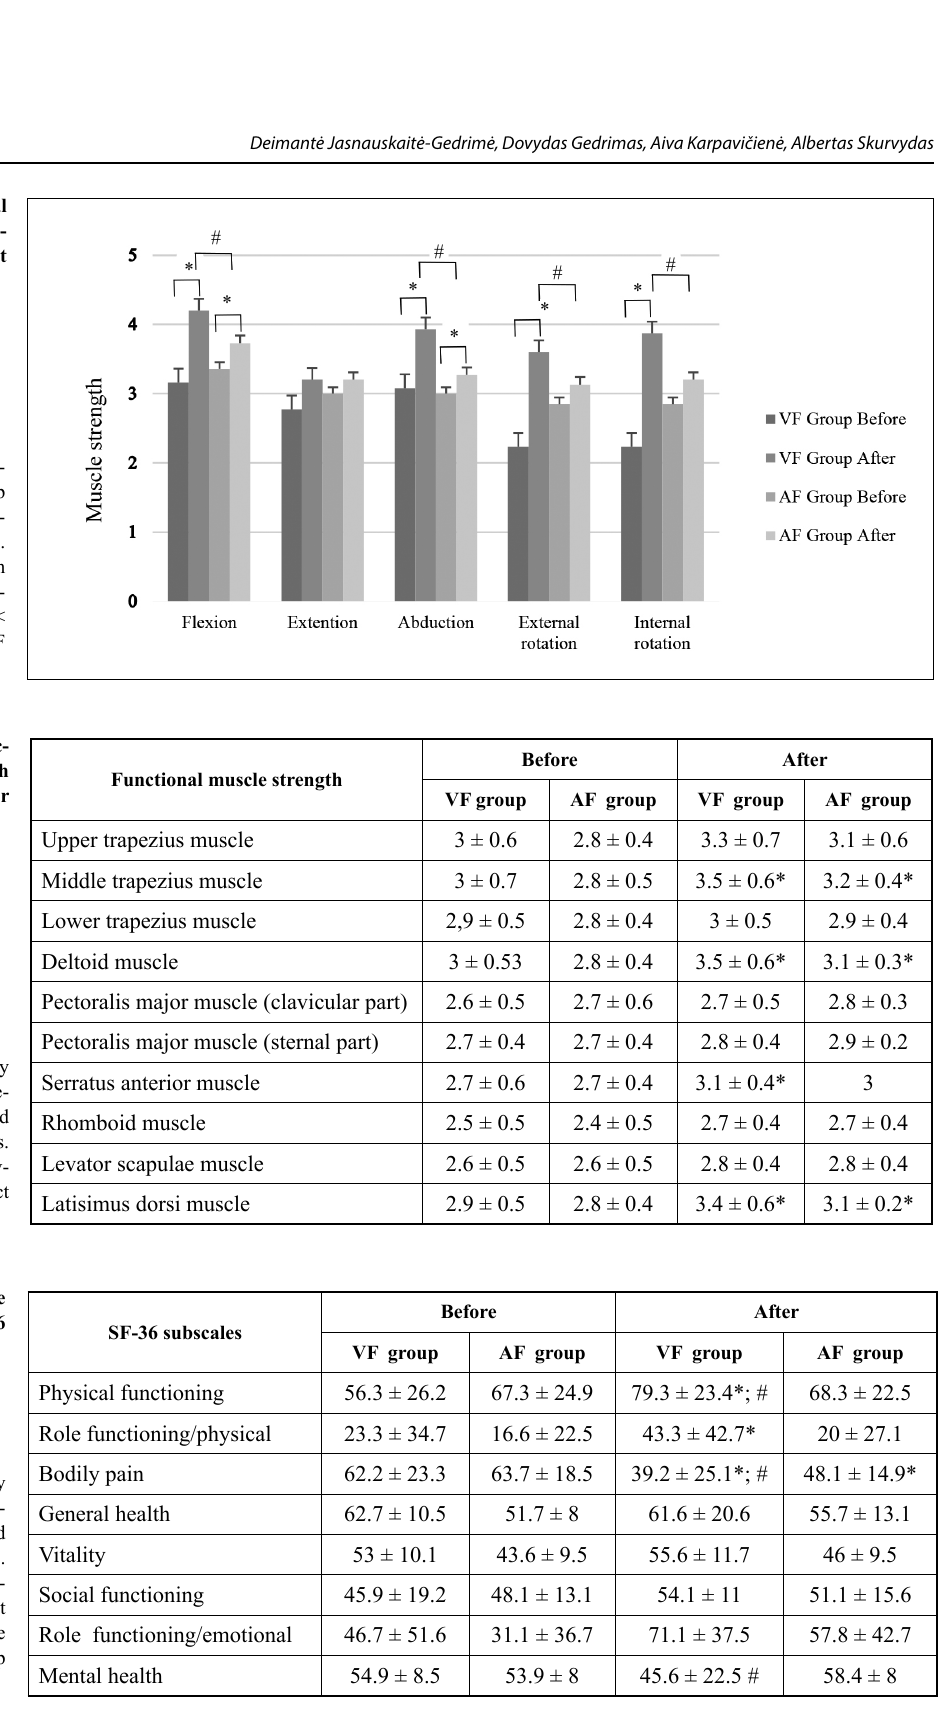
anterior – 15% and latisimus dorsi muscles – 20.93%. In AF group, statistically significant ( p < .05) muscle strength increase was found in middle trapezius – 11.63%, deltoid – 11.6%, and latisimus dorsi muscles – 9.52%. .05) between groups. Also statistically significant ( p < .05) difference was found in the mental health section of the